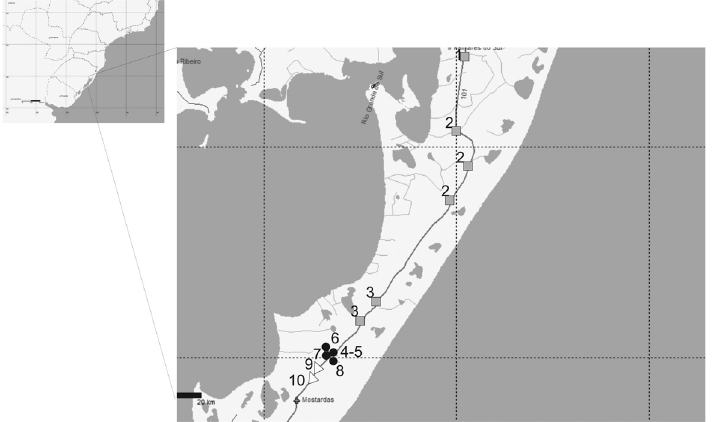
Figure 1 - Sampling sites of individual Ctenomys minutus from populations fixed for 2n = 48a (gray squares) or 2n = 42 (white triangles), both collected by Gava and Freitas (2003), and polymorphic populations 2n = 42-46 (black circles), collected for this study from a contact zone on the coastal plain of southern Brazil. Abbreviations for sampling locations are shown in Table